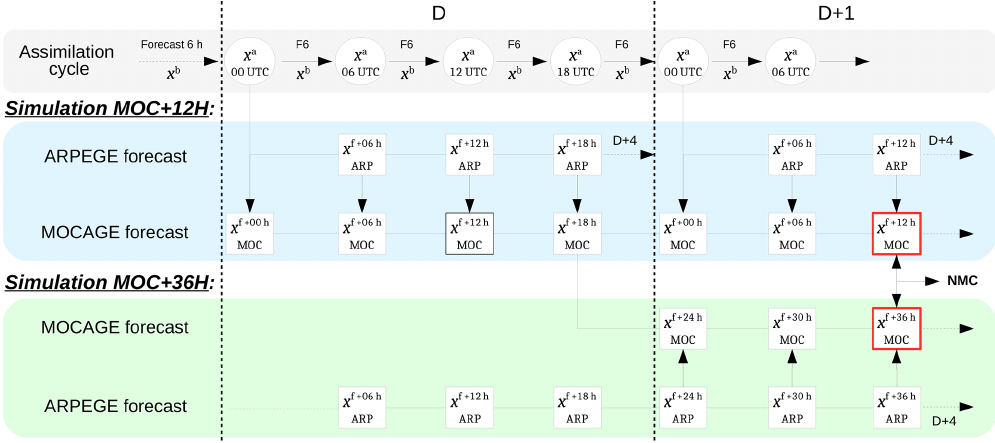
+ 12h is the forecast from simulation MOC+12H that MOC